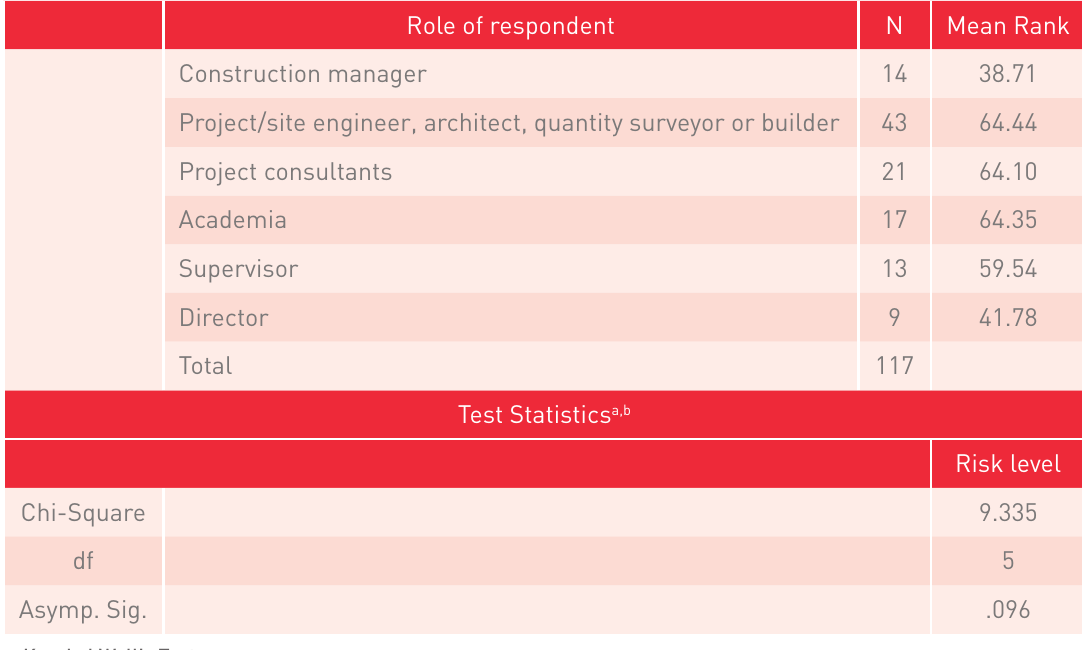
Table 7. Kruskal Wallis H Test for comparing the risk level based on the respondents’ role Role of